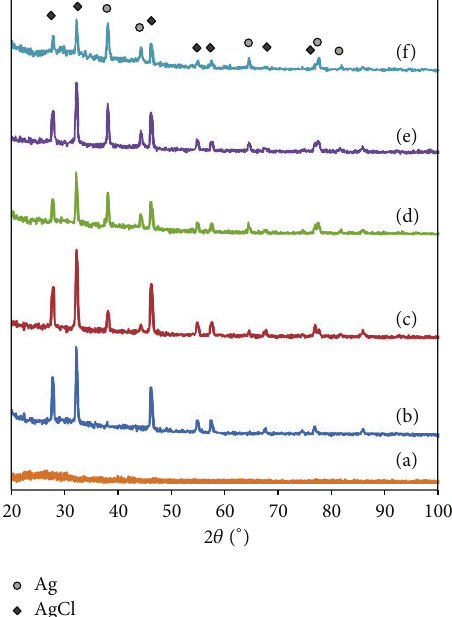
Figure 5: XRD patterns of HCl functionalized 𝛼 CNTH/Ag nanohy- brids at different molars of AgNO 3 : (a) 0 M, (b) 0.01 M, (c) 0.05 M, (d) 0.1M, (e) 0.5 M, and (f) 1M.